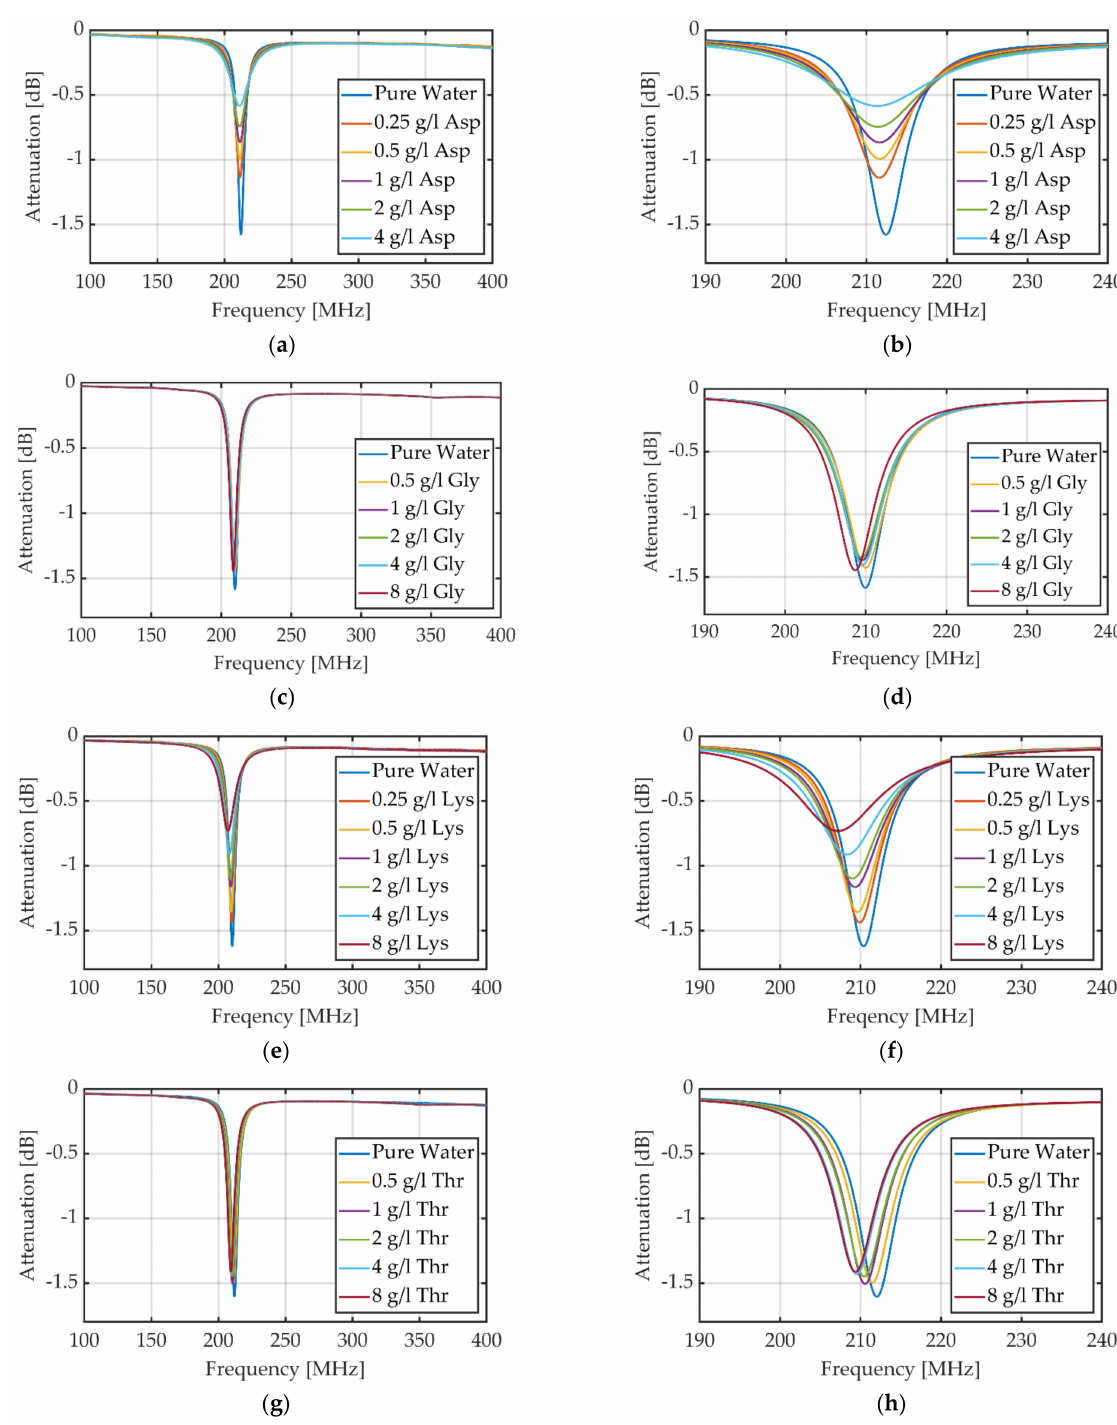
Figure 5. Frequency responses for different concentrations of aspartic acid (Asp) ( a , b ), glycine( c , d ) lysine (Lys) ( e , f ) and threonine (Thr) ( g , h ). The left diagrams show the full frequency spectrums from 100 MHz to 400 MHz for the different concentrations of the four samples. The right diagrams show the same measurements zoomed in to 190 MHz to 240 MHz for better